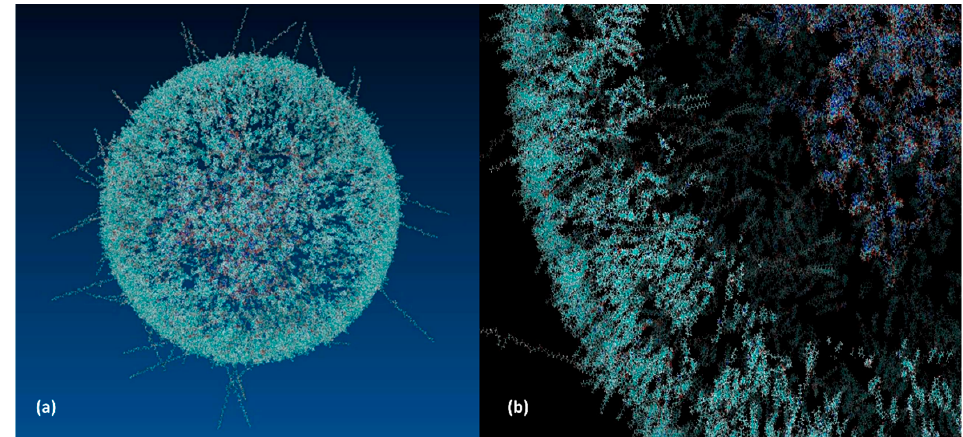
Figure 8. Molecular graphics of the: ( a ) lipid nanoparticle unit; ( b ) the made-transparent surface section, showing the encapsulated mRNA constructs occupying the nuclear area.